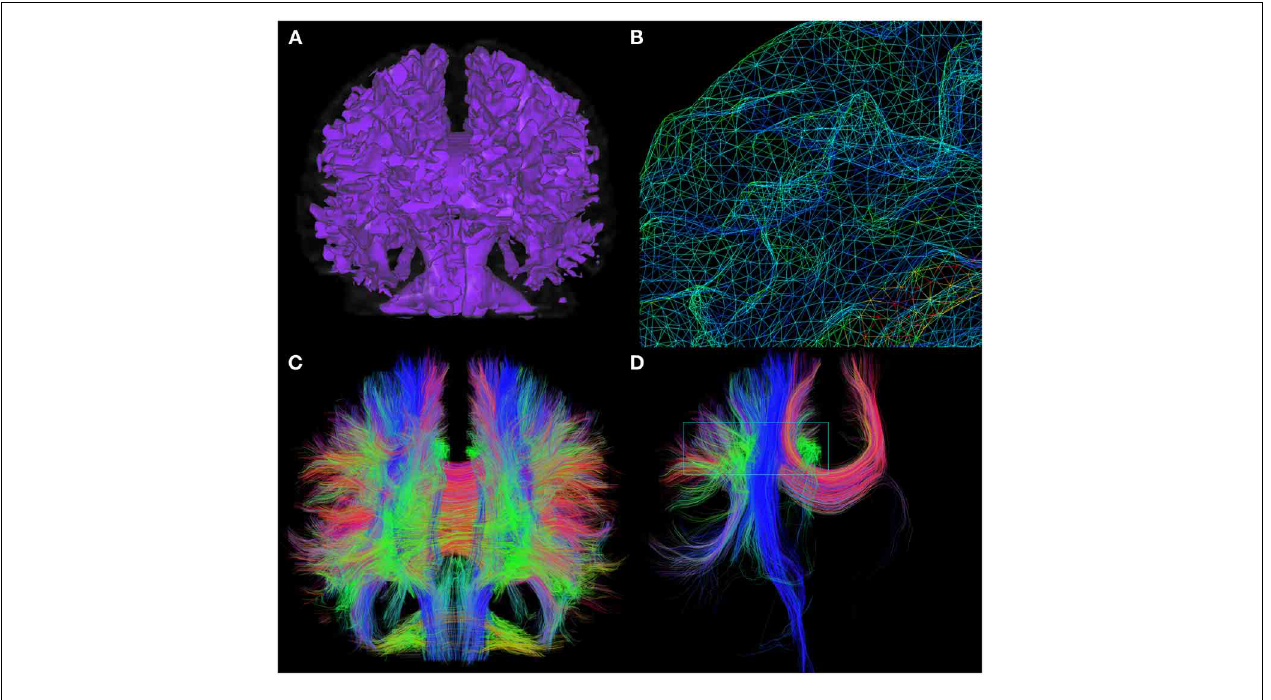
FIGURE 3 | Whole brain fiber tractography obtained via the shell-seeding option. In (A) an isosurface is generated from an anatomical T1 map to fit the boundaries of GM/WM matter interface. Seed points are